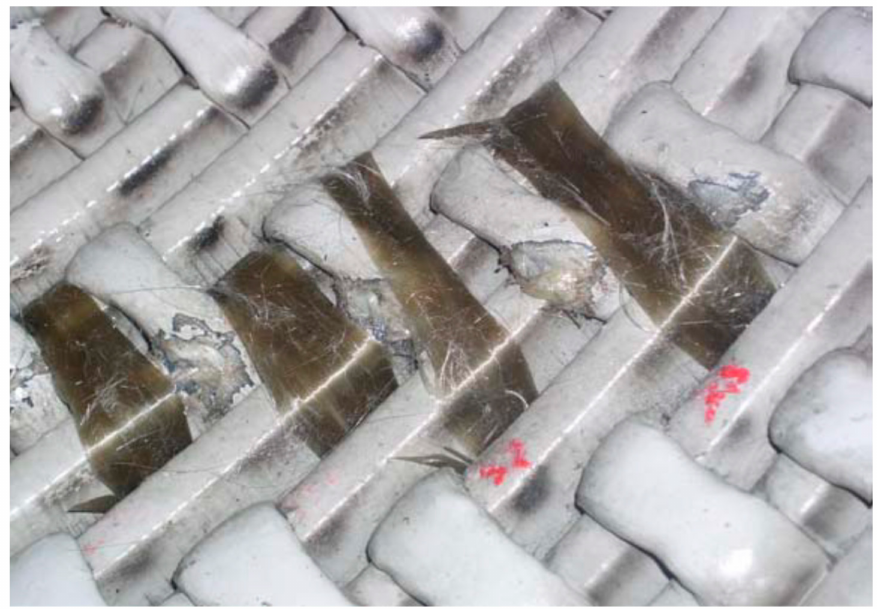
Figure 3. Restored ties with glass roving and resin.